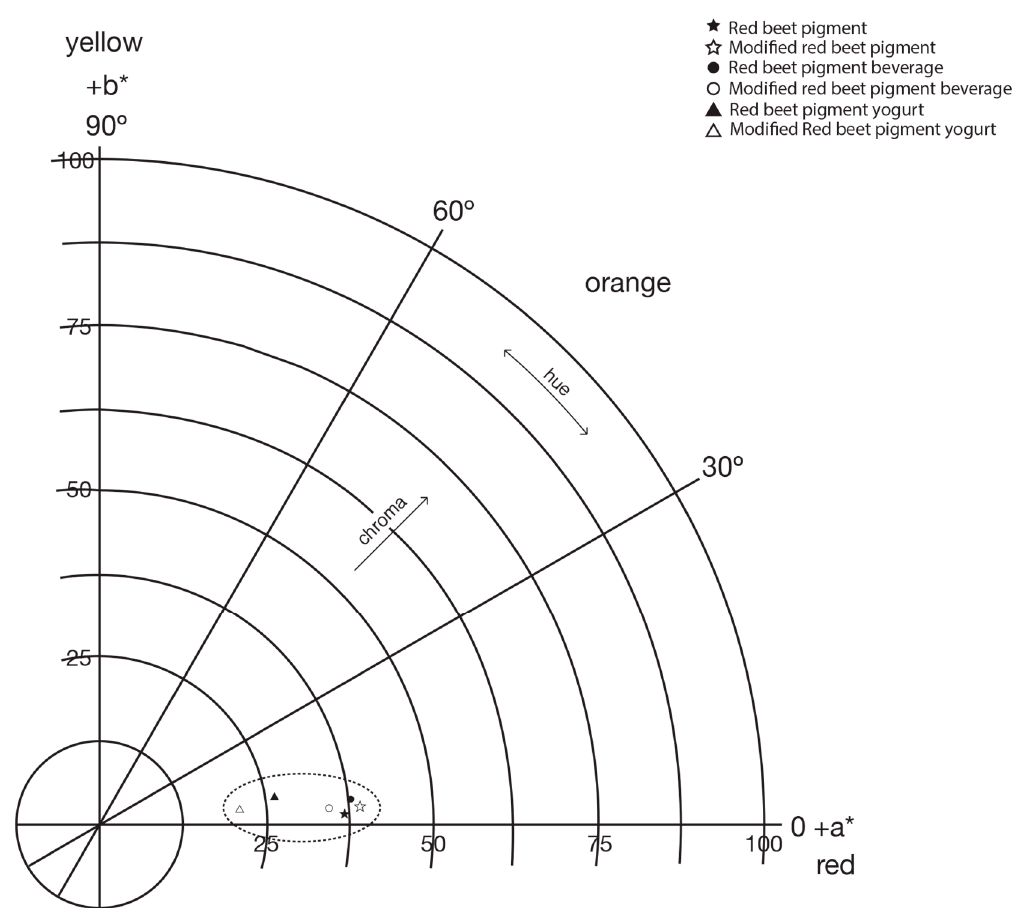
Figure 5. Polar color diagram for red beet pigments before and after the chemical modification process and applied to beverage and yogurt model